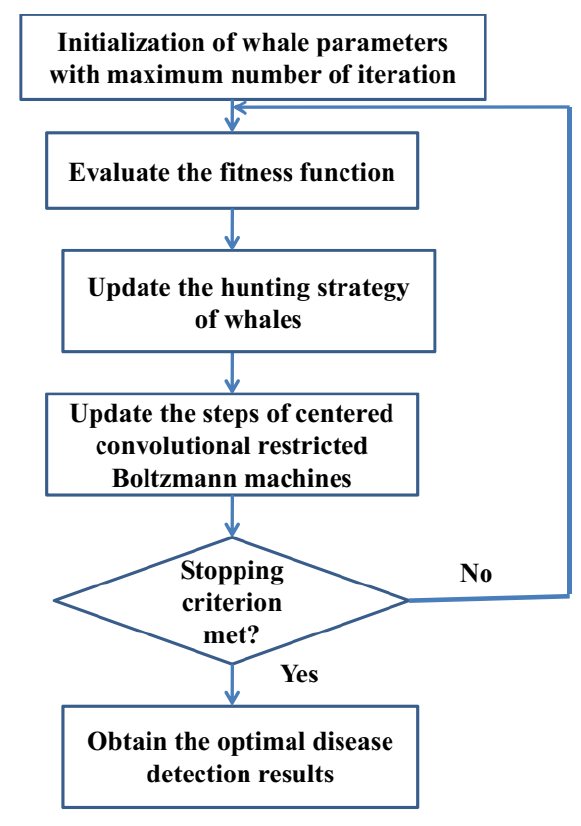
Figure 3. Proposed CCRBM-based WO algorithm for disease detection.